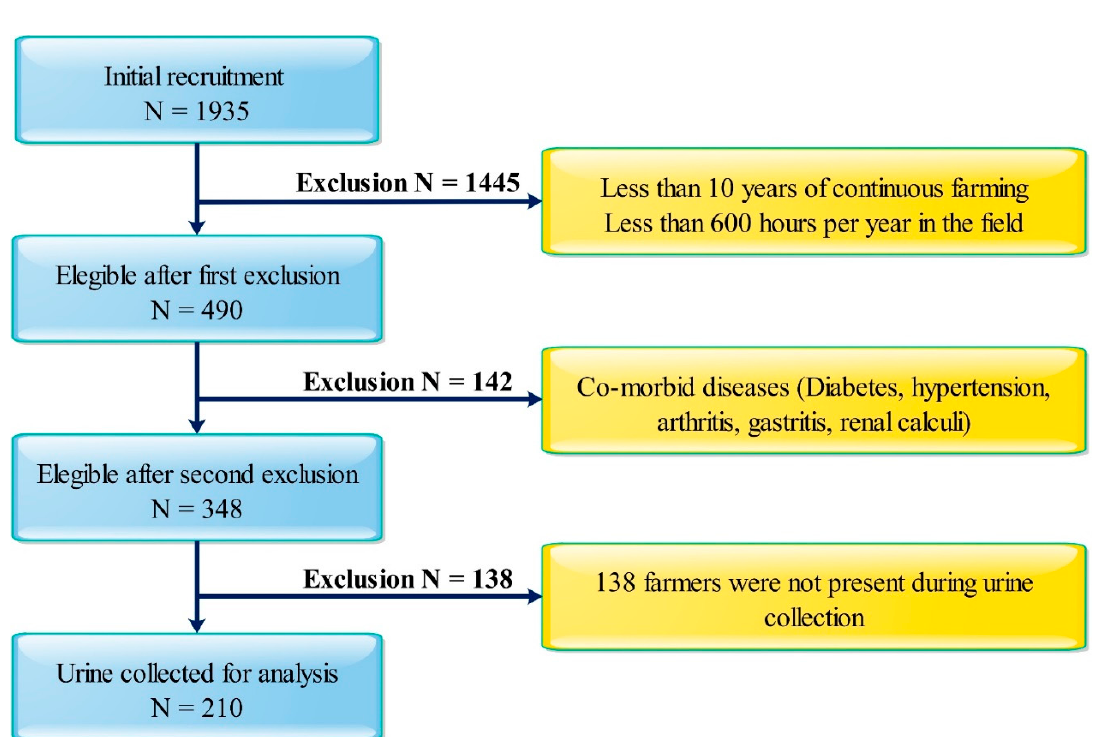
Figure 2. Flow chart representing study population and study design in CKDu emerging locations (RH and WA) and non-endemic location (MA). Here would be useful to say how many farmers per location.